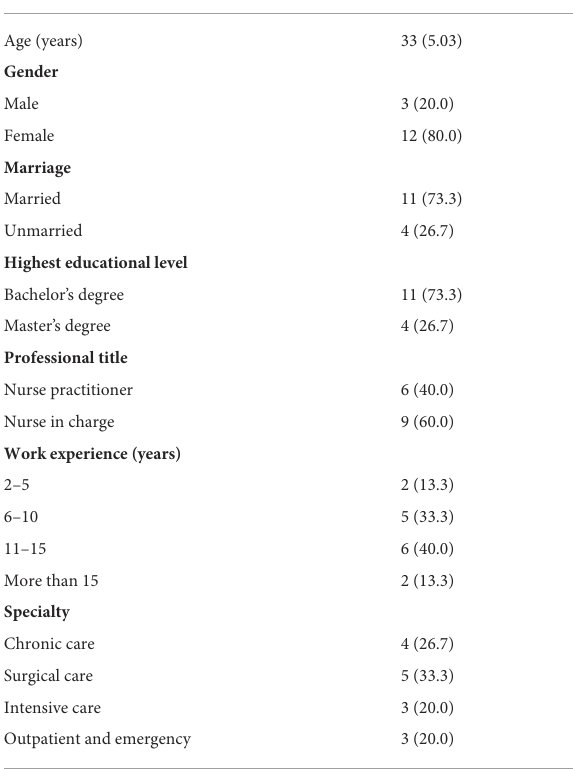
TABLE 1 Participants’ characteristics ( n =